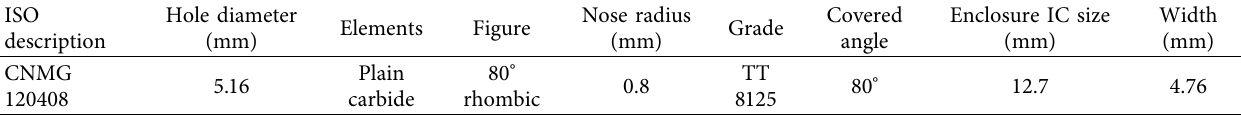
Table 2: Detailed description of the equipment.